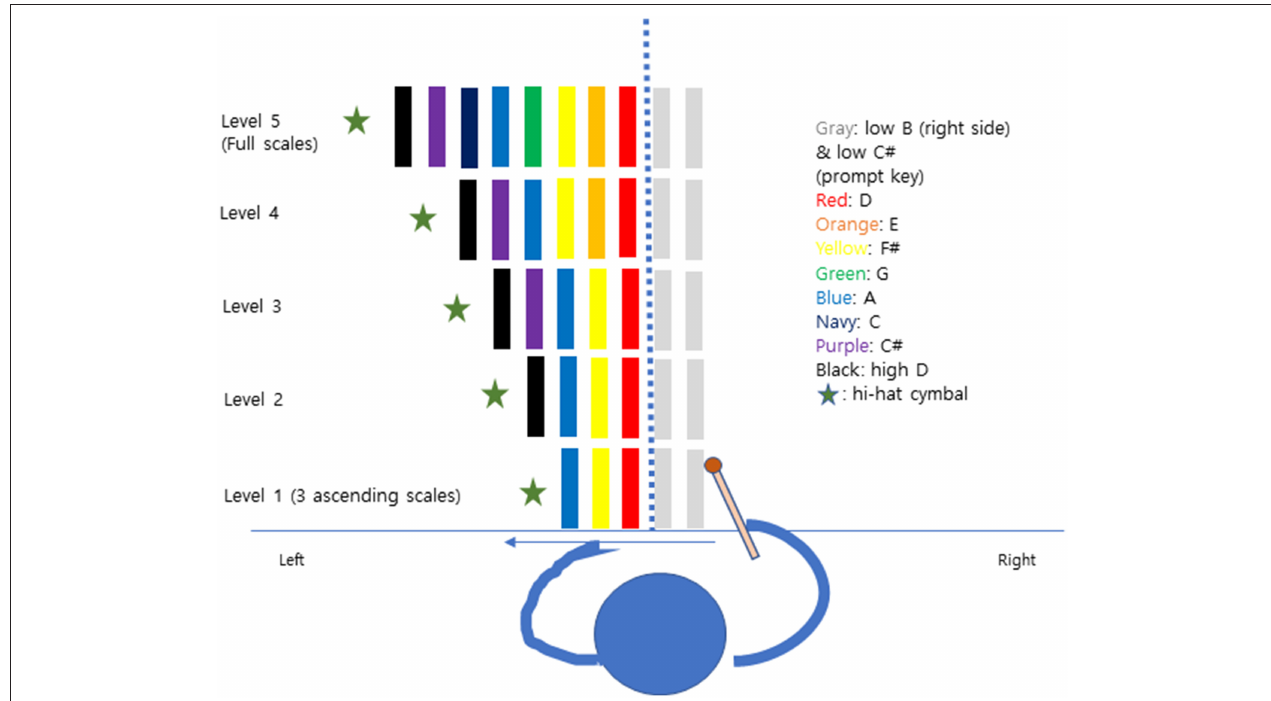
FIGURE 1 | The five levels of musical neglect